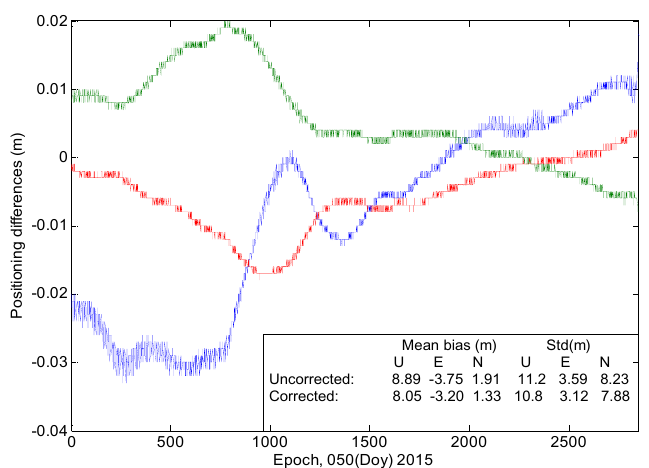
Figure 22. “Positioning difference” is the differences between kinematic PPP estimations with and without employing the correction model. “Uncorrected” indicates the results when the code bias is not corrected; “Corrected” indicates the results after the model has been applied.